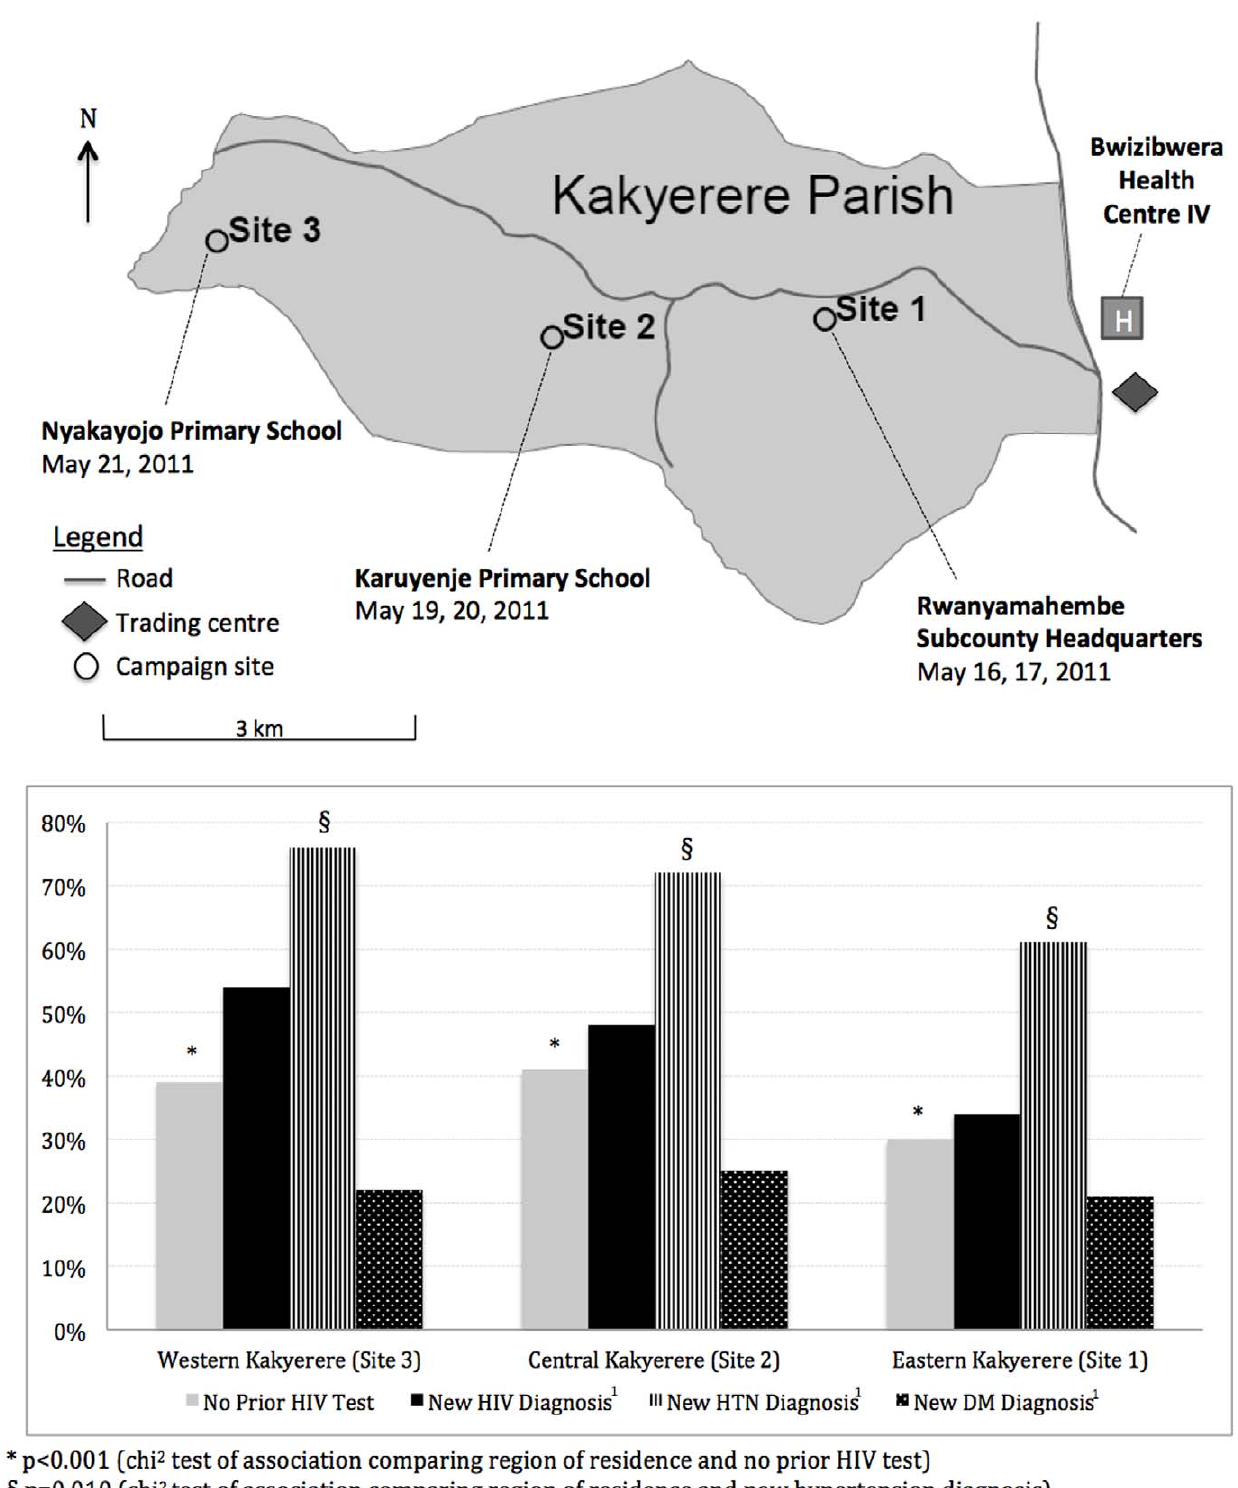
Figure 1. Map of Kakyerere Parish. Location of Campaign Sites and the Relationship Between Prevalence of Undiagnosed Disease among Adult Parish Residents and Increasing Distance from the Local Health Centre.